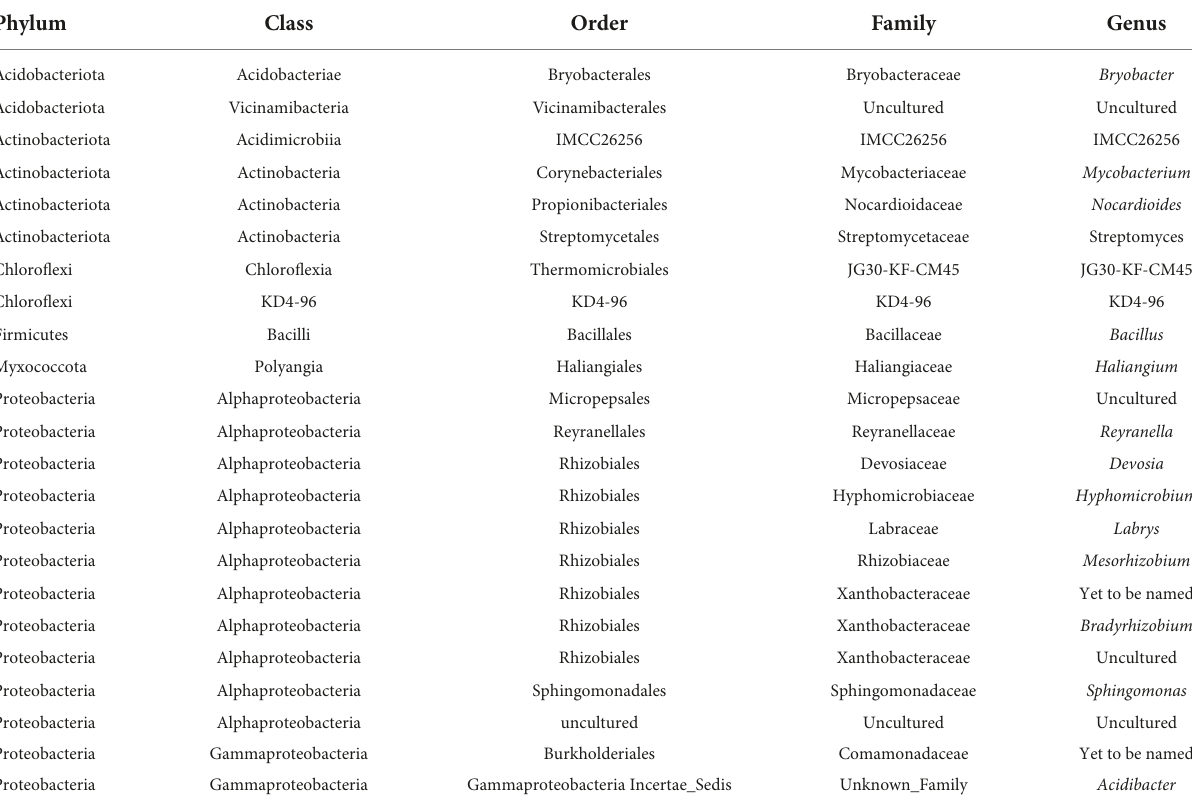
TABLE 3 Bacteria at genus level of classification present in 64 samples collected at Indiana Dunes National Park in